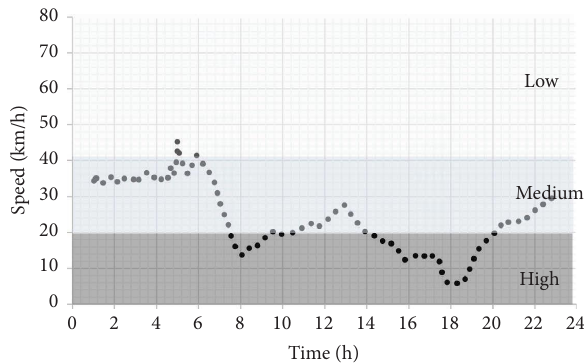
Figure 1: Levels of trafc congestion considering speed and dif- ferent blocks of